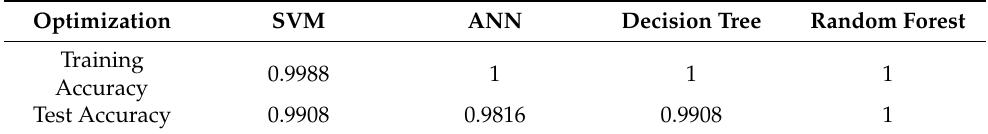
Table 9. Optimal classification results.